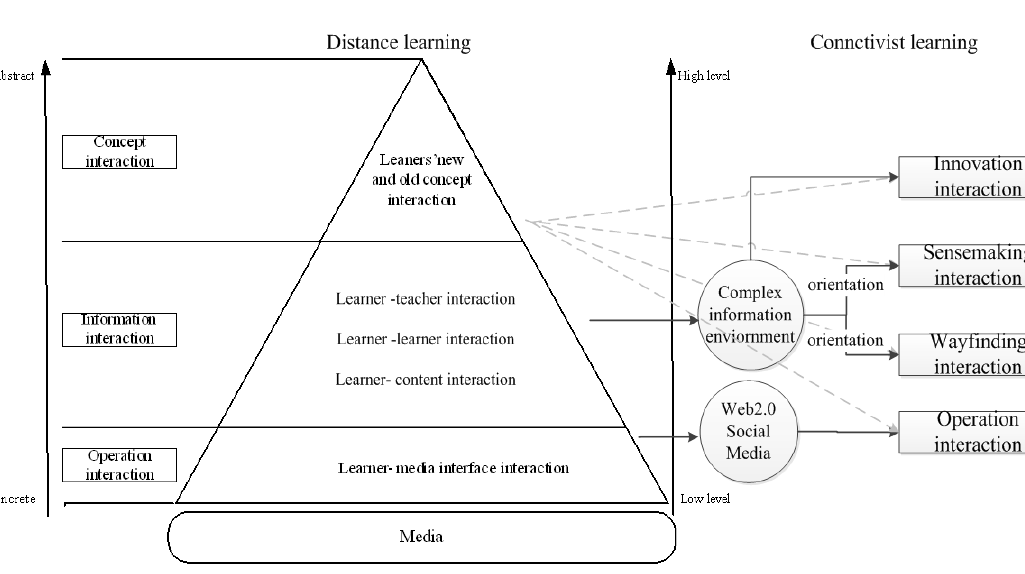
Figure 2. Conceptual development of interaction in connectivist